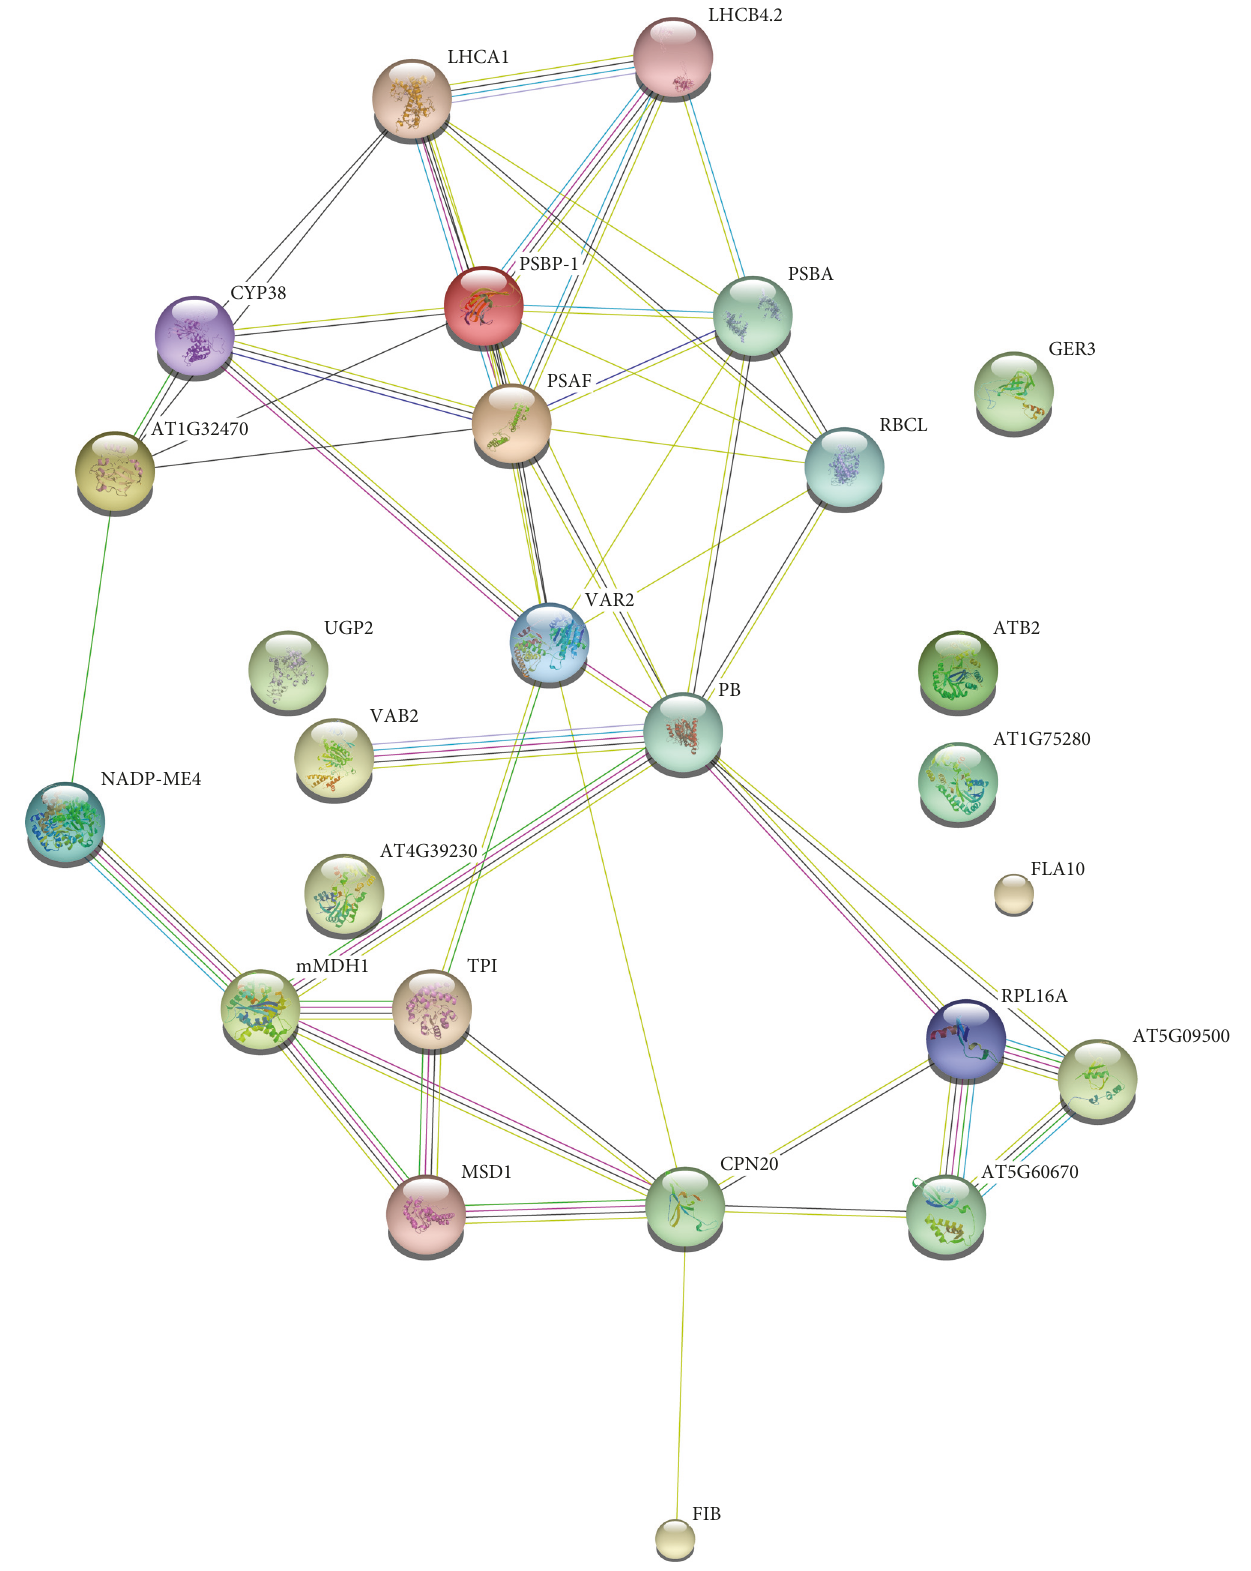
Figure 4: Functional networks of the identi fi ed PaWB-related proteins. Di ff erent line colors represent the types of evidence used in predicting the associations: gene fusion (red), neighborhood (green), cooccurrence across genomes (blue), coexpression (black), experimental (purple), association in curated databases (light blue), text mining (yellow), and homology (light